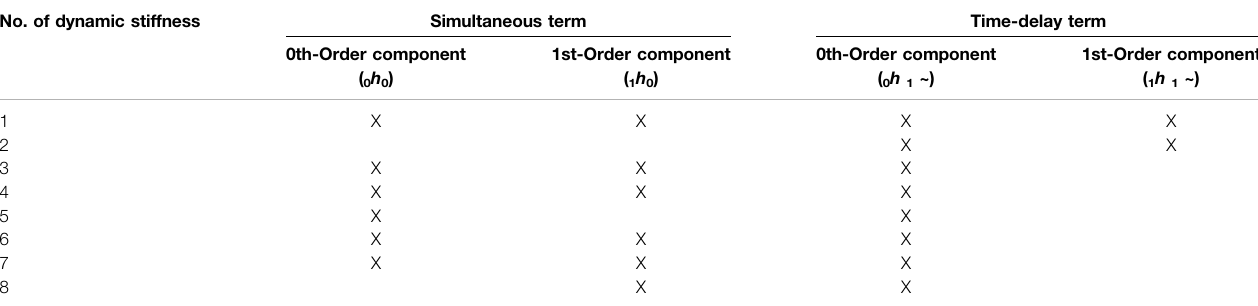
TABLE 1 | Components of each case in the time domain. No. of dynamic